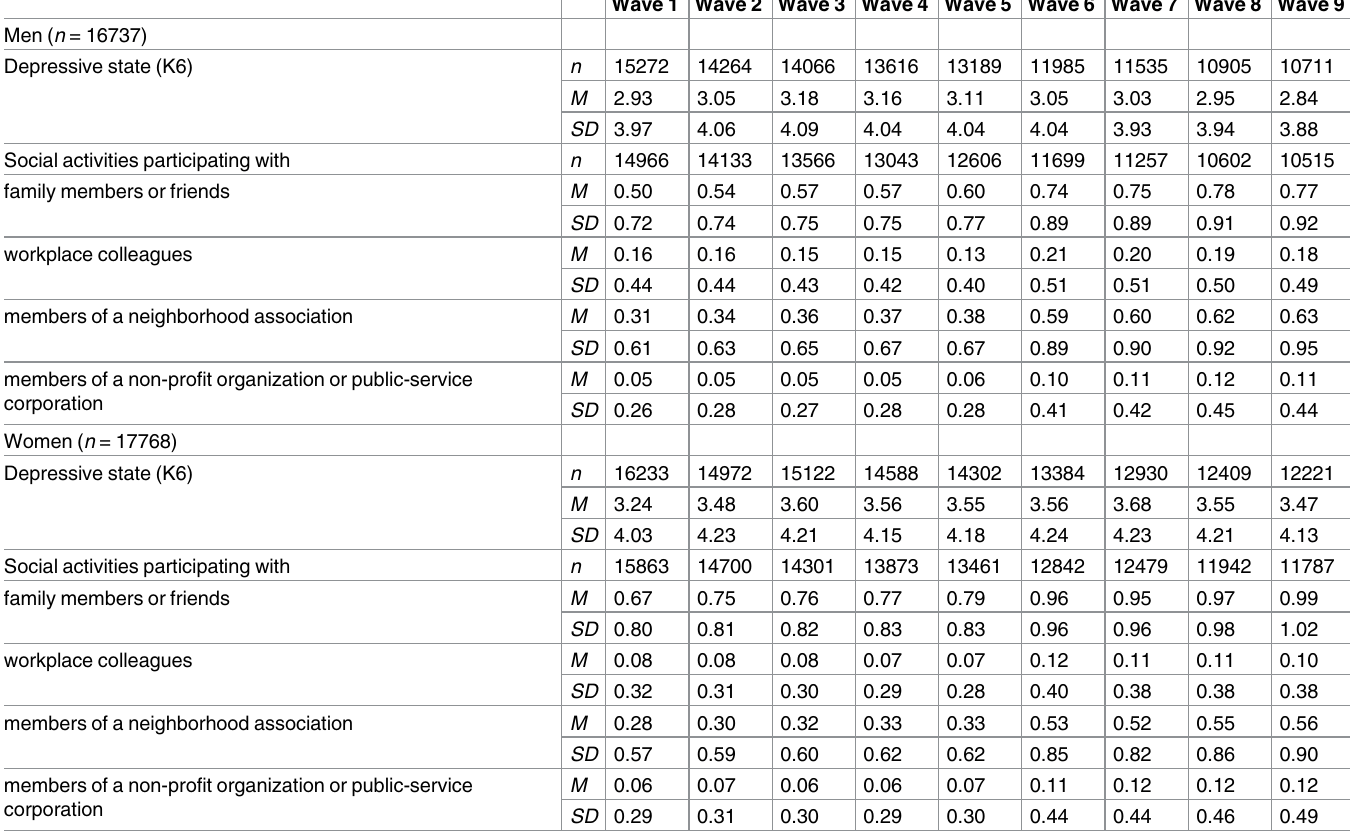
Table 2. Descriptivestatistics about depressivestate across the nine waves by